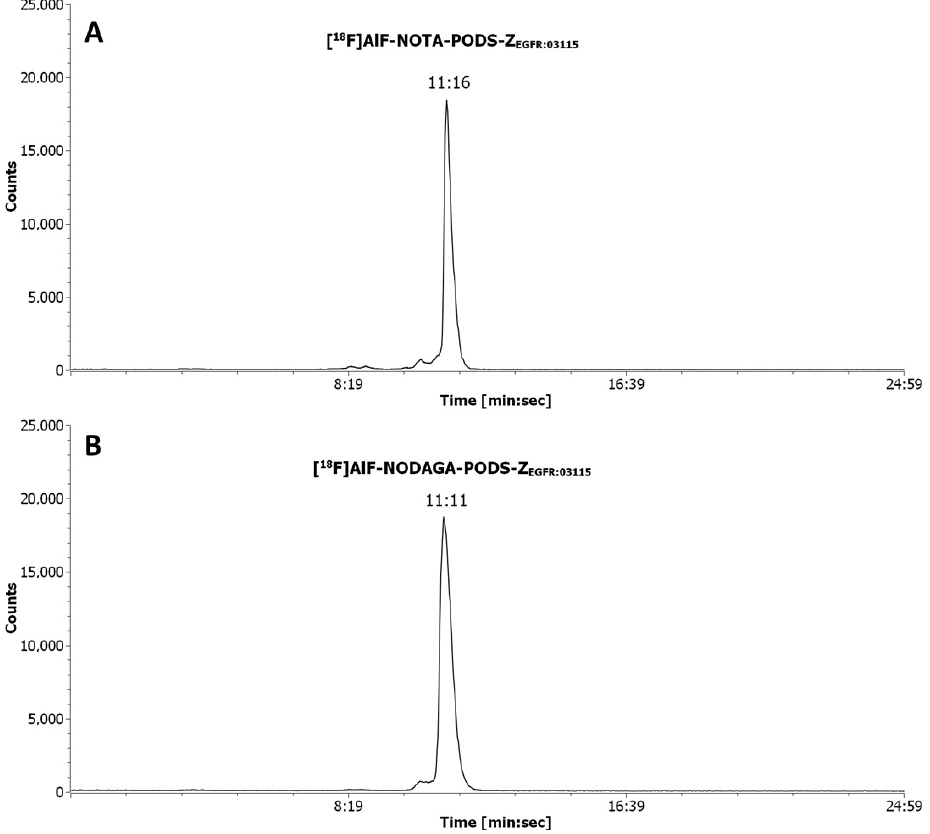
Figure 2. Radiochromatograms of pure [ 18 F]AlF-NOTA-PODS-Z EGFR:03115 ( A ), and [ 18 F]AlF-NODAGA- PODS-Z EGFR:03115 ( B ). The retention time (Rt) is indicated as min:sec.